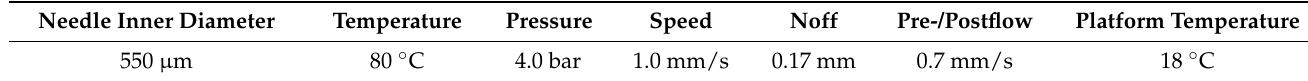
Table 1. Parameters for 3D Printing.